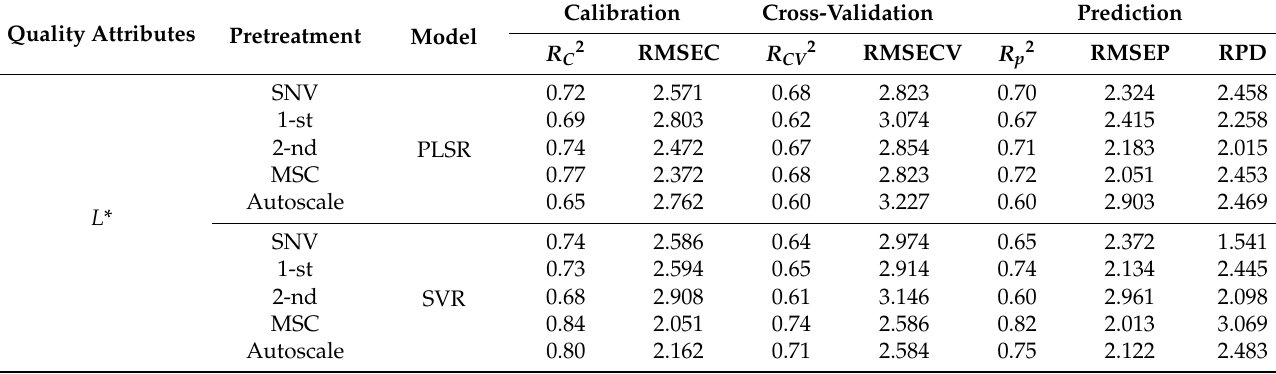
Table 3. Performance of the regression models for surface color of individual mini-Chinese